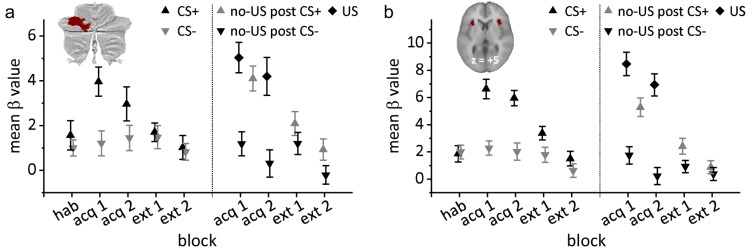
Group mean β values related to each event (presentation of US, CS+, CS-, omission of US) compared to rest.(a) Volume of interest (VOI) in the left cerebellar hemisphere; (b) VOI in the bilateral insula. Error bars represent standard errors. acq 1, acq 2 = early and late acquisition; CS = conditioned stimulus; ext 1, ext 2 = early and late extinction; hab = habituation; US = unconditioned stimulus.10.7554/eLife.46831.015Figure 5—source data 1.Mean β data.